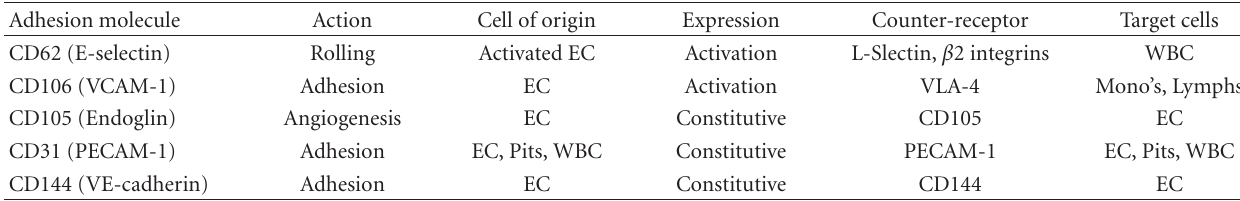
Table 1: EC-associated CAM panel for the analysis of EMPs.